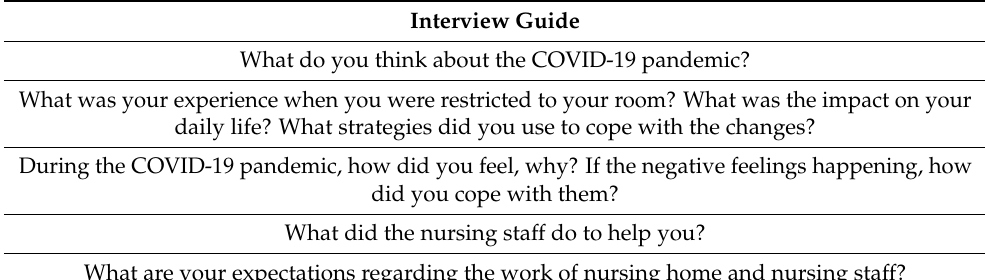
Table 1. Interview guide for the participants.